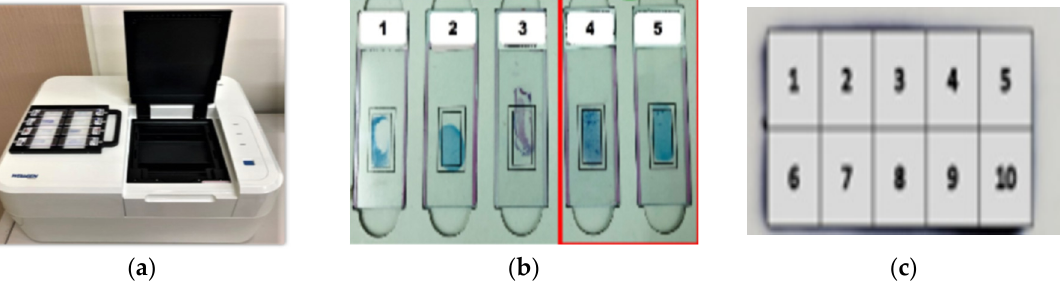
Table 5. The precision and error rate of the automation system and manual microscopy. The “True” represents the cases diagnosed correctly; The “False” represents the cases of wrong diagnosis.